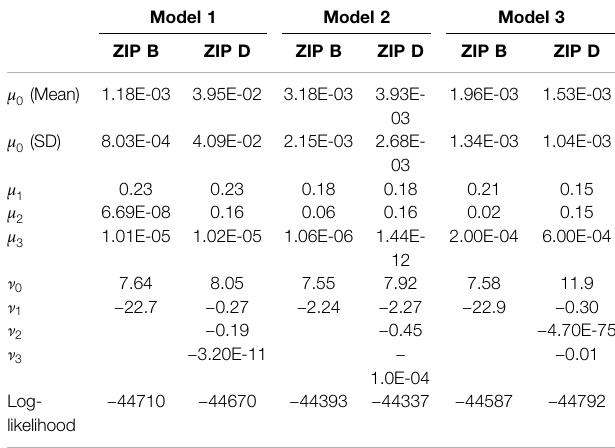
TABLE 2 | Parameter estimates (normalized components) and resulting log- likelihood for each